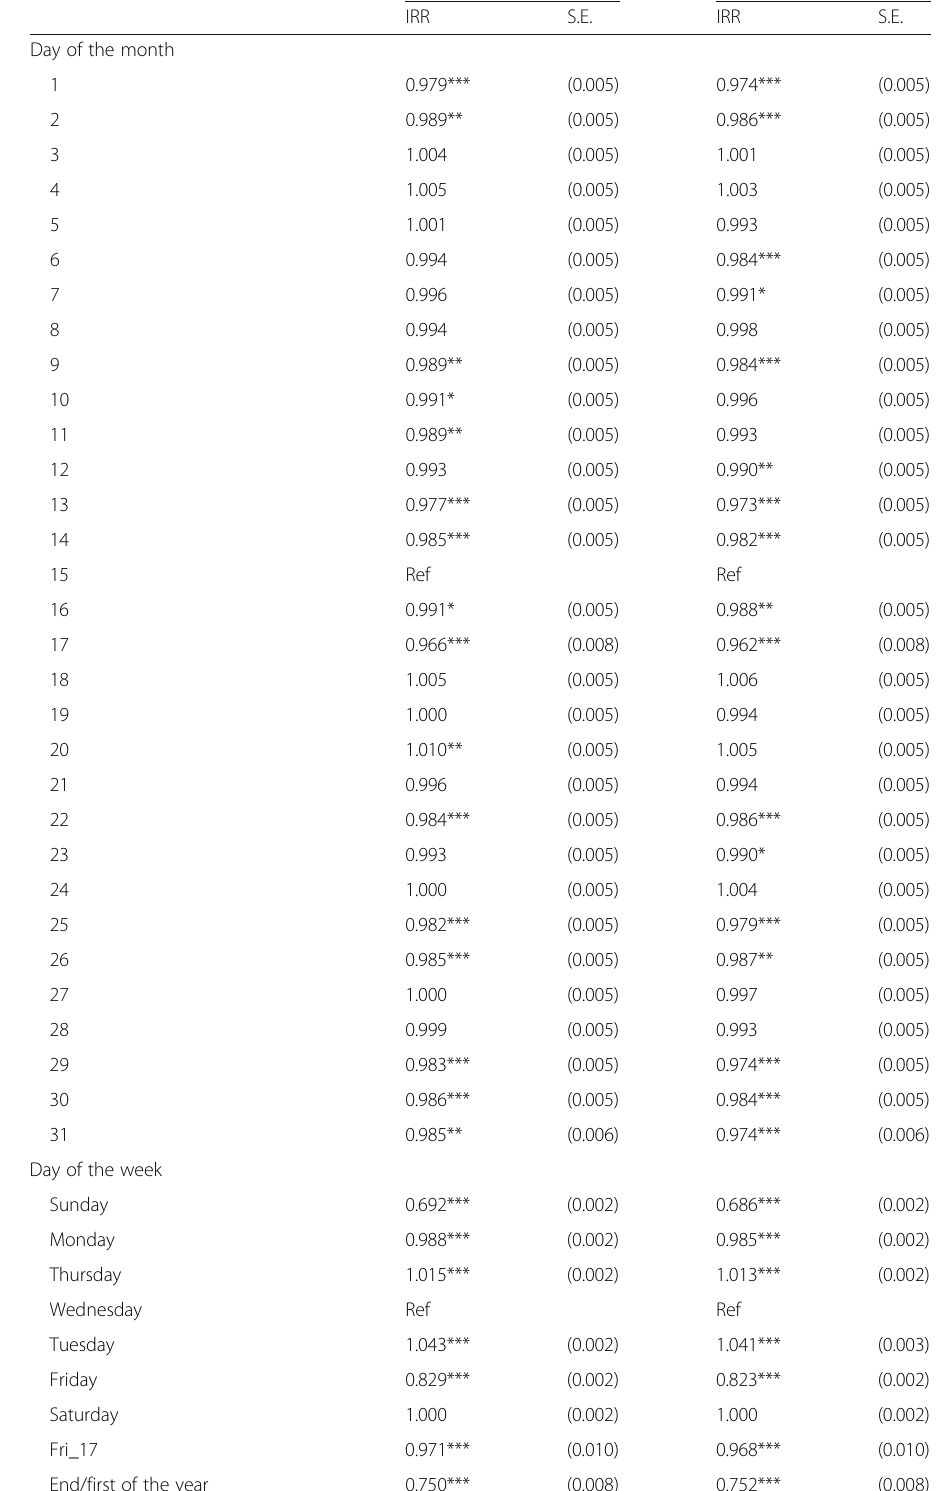
Table 4 The calendar effect on the daily births pooling macro-regions